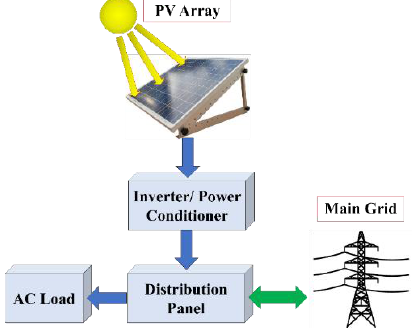
Figure 1: Structure of a solar energy system.